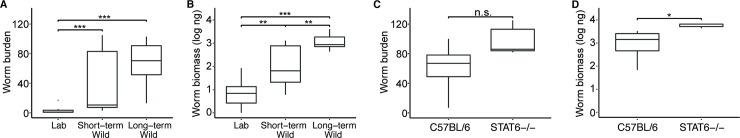
Trichuris muris worm burdens and worm biomass in C57BL/6 mice in laboratory versus outdoor environments at 3 weeks p.i.(A) Worm burdens and (B) worm biomass from infected C57BL/6 mice residing in laboratory and outdoor environments at 3 weeks p.i. Lab: N = 8; Short-term Wild: N = 10; Long-term Wild: N = 10. (C) Worm burdens and (D) worm biomass from C57BL/6 and STAT6-/- mice residing outdoors for the short-term at 3 weeks p.i. C57BL/6: N = 4; STAT6-/-: N = 5. Box centers show the medians, and the upper and lower box edges correspond to the 25th and 75th percentiles. Whiskers extend 1.5 times the interquartile range. Please see Materials and methods for further information on potential sources of variation and associated statistical tests. Asterisks denote significance as *P < 0.05, **P < 0.01, ***P < 0.001. https://doi.org/10.5061/dryad.h9g697r. ng, nanograms; n.s., not significant; p.i., postinfection; STAT6-/-, mouse deficient in STAT6.